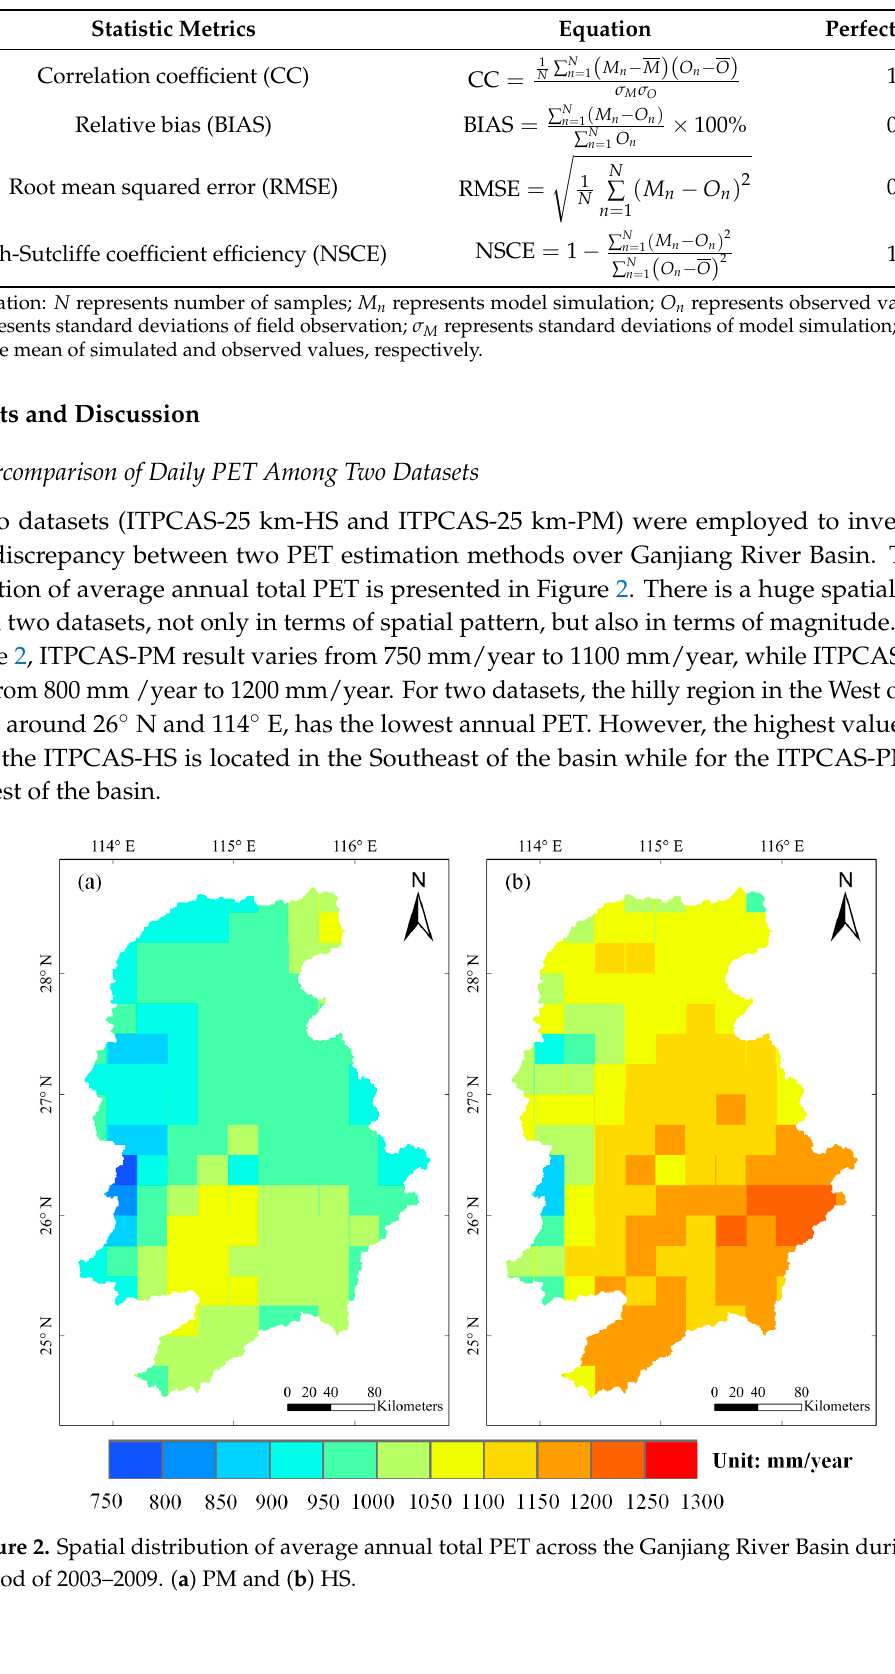
Table 2. Statistical metrics used in the evaluation and comparison.